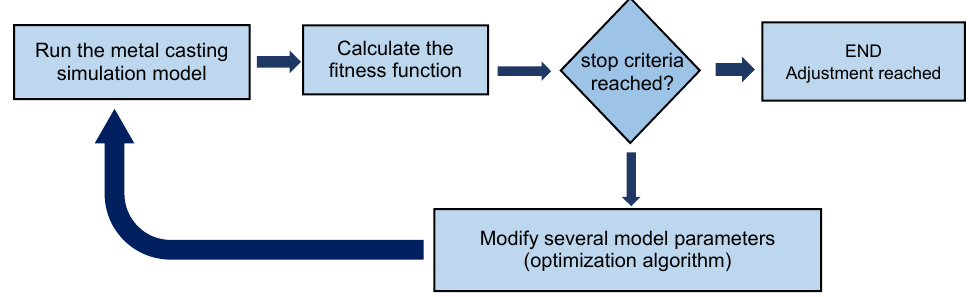
Figure 1. Flowchart of the model adjustment procedure.